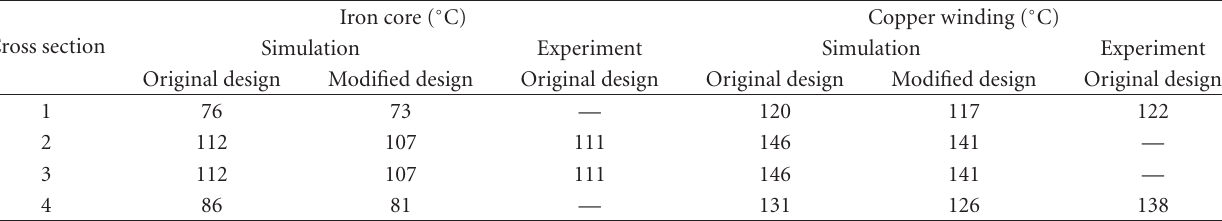
Table 4: Numerical and experimental results for the stator